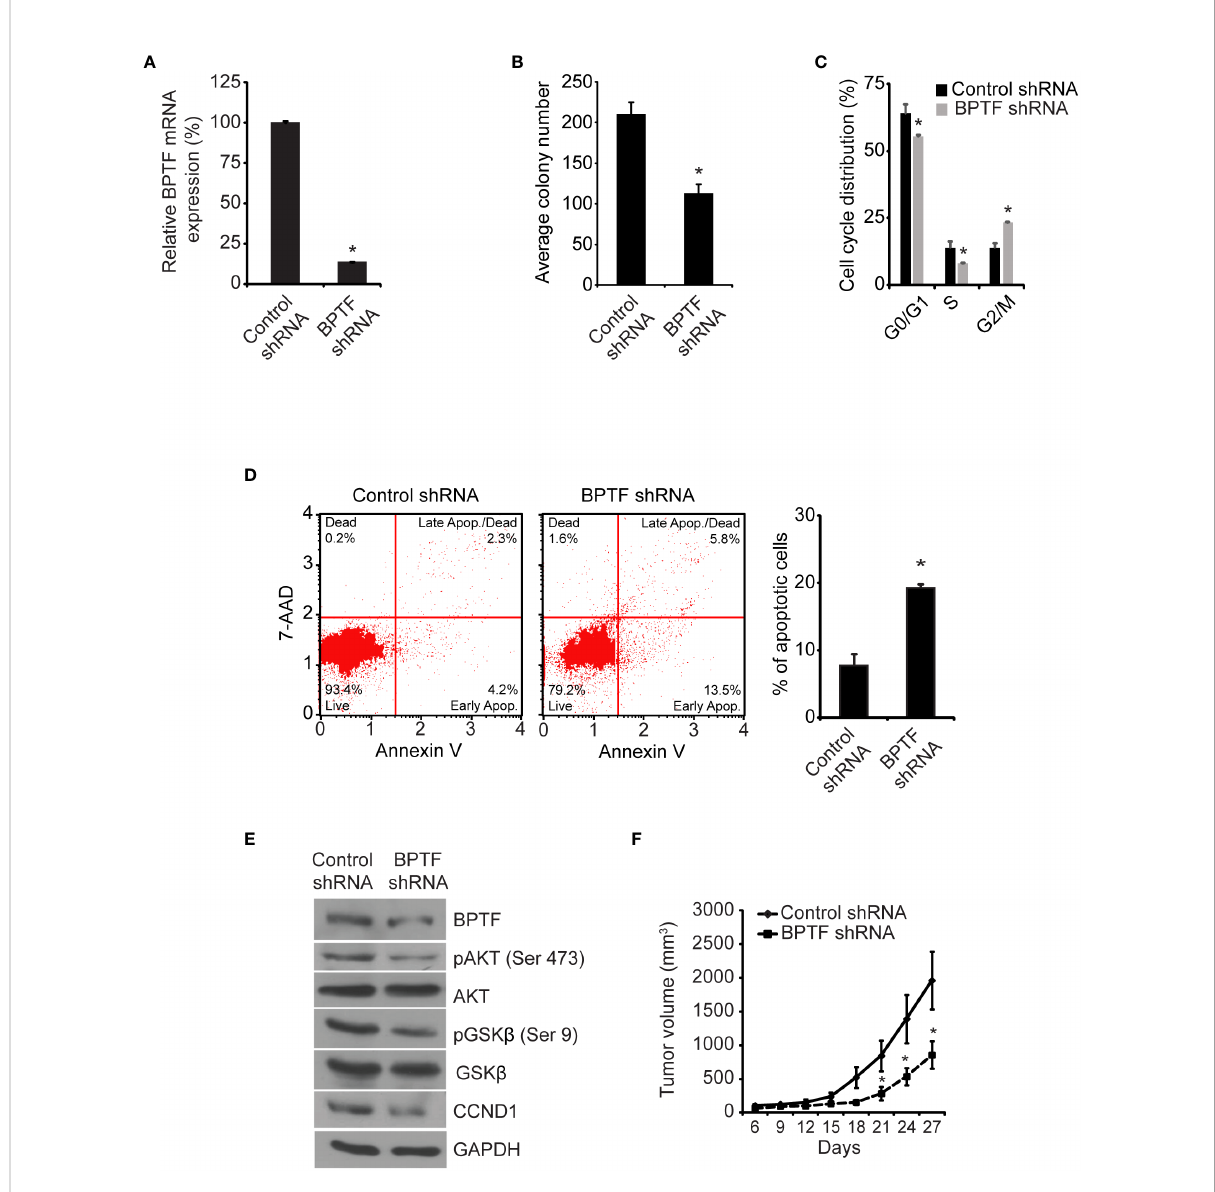
FIGURE 2 Effects of shRNA-mediated suppression of BPTF on MDA-MB-231 cells. (A) BPTF mRNA levels following shRNA-mediated suppression. (B) Mean colony number after BPTF suppression. (C) Cell cycle phases following BPTF knockdown. (D) Analysis of apoptotic rate after BPTF silencing based on detection of 7-AAD and Annexin V. (E) Western analysis of expression of various proteins following shRNA-mediated BPTF knockdown. (F) In vivo tumor cell growth following shRNA-mediated suppression of BPTF . *p <